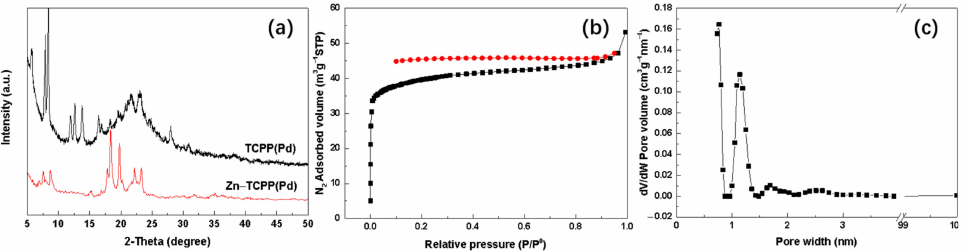
Figure 4. ( a ) XRD patterns of TCPP(Pd) and the prepared Zn–TCPP(Pd) MOF nanosheets, ( b ) N